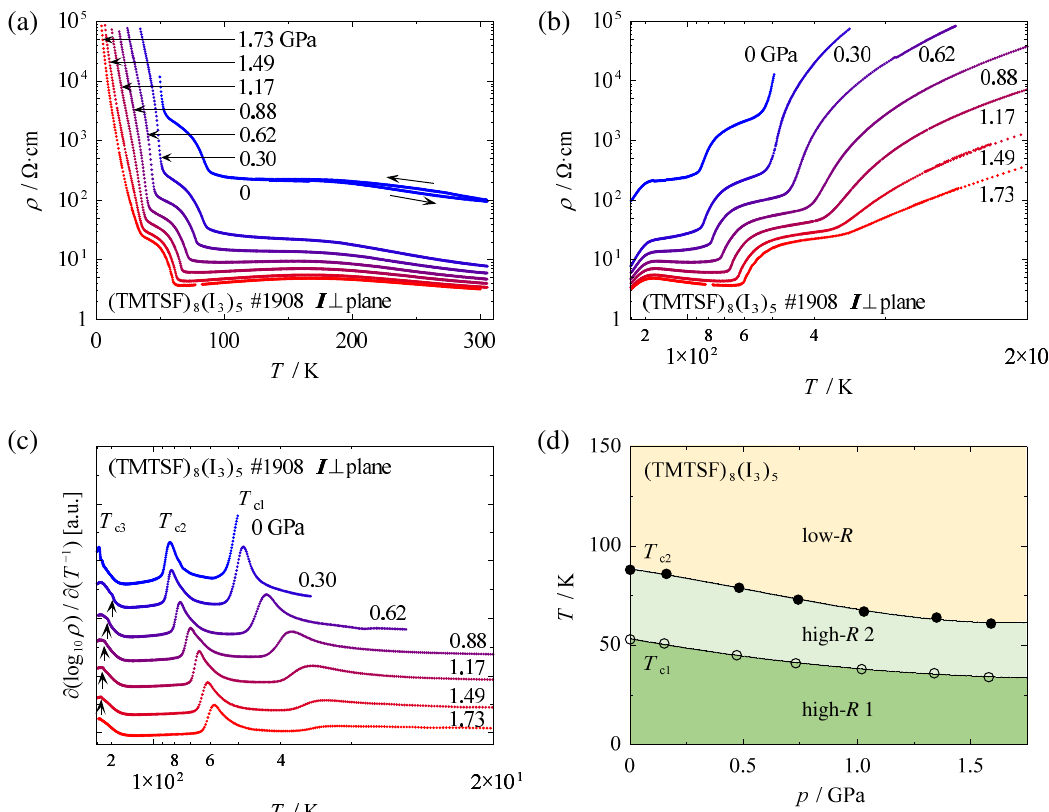
Figure 4. ( a ) Temperature dependence of the electrical resistivity ρ of (TMTSF) 8 (I 3 ) 5 measured perpendicular to the most grown crystal surface. ( b ) Arrhenius plot of the same data in ( a ). Please note that the values in the horizontal axis is T but the scale is linear in T − 1 . ( c ) Numerical derivative of the Arrhenius plot in ( b ) calculated after smoothing the data. A series of data at each pressure was shifted from one another for clarity. The arrows at high temperatures indicate the subtle anomalies caused by the solidification of the pressure medium (see text). ( d ) Temperature–pressure phase diagram of (TMTSF) 8 (I 3 ) 5 below 150